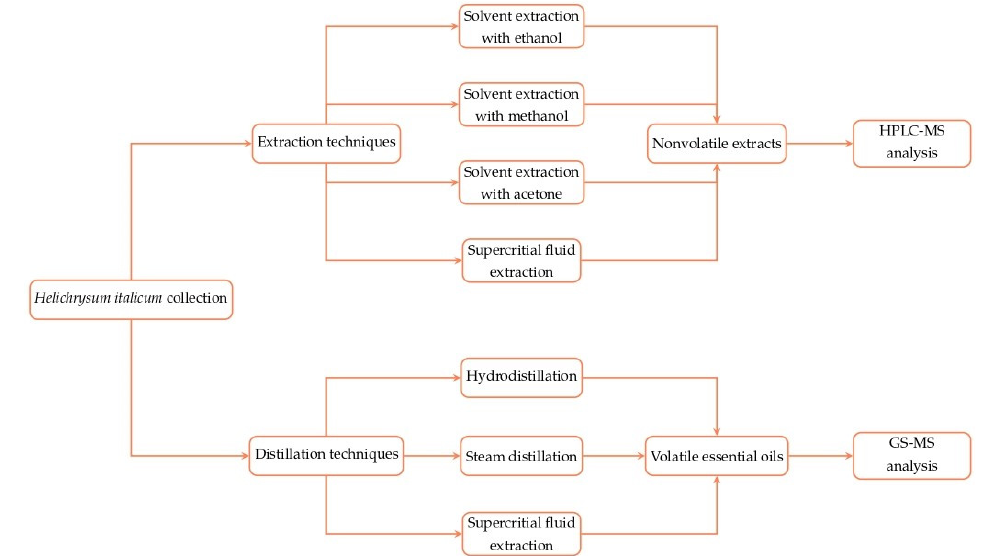
Figure 2. Pipeline process from Helichrysum italicum collection to the identification of bioactive compounds.